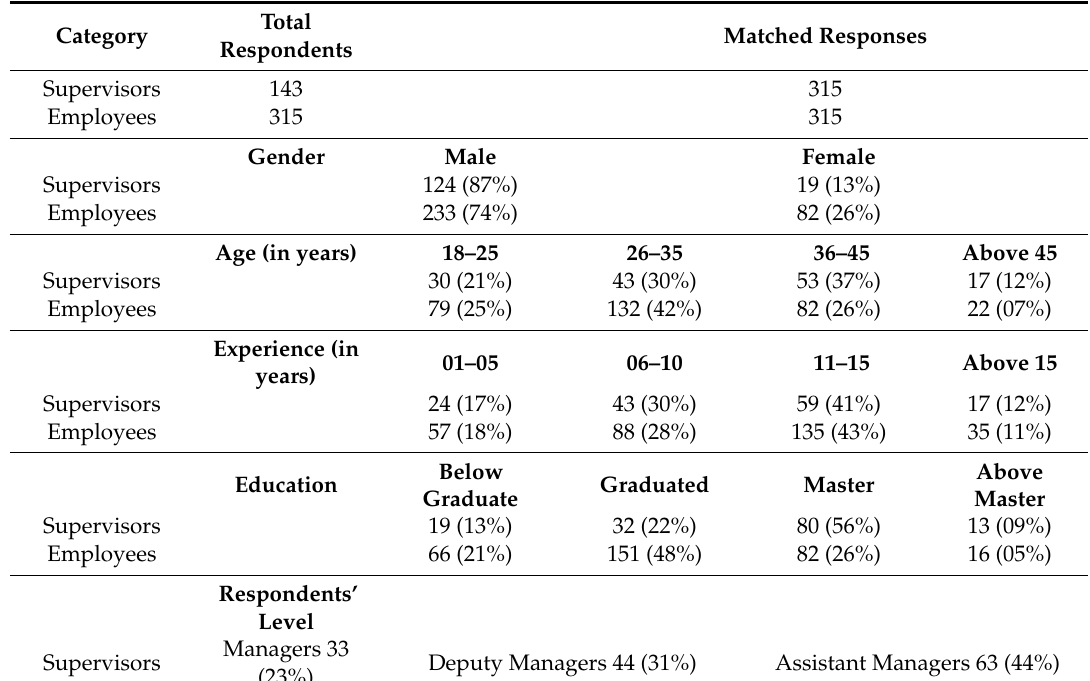
Table 1. Demographics of the